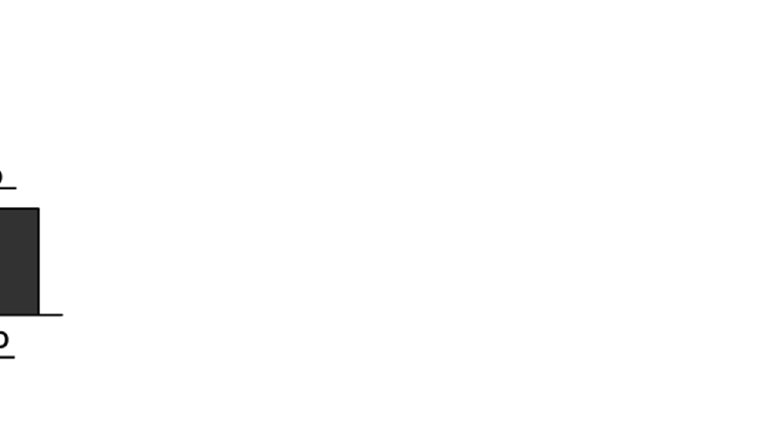
Figure 10. Partial replacement of dietary fat with PO or CO and LPS challenge on mRNA expression related to inflammation in EAT. Mice were fed either an ND or an ND partially replaced with PO or CO for 12 weeks and then treated with LPS (1 mg/kg) for 24 h ( n = 8 per group). ( A ) Interleukin (IL)-6 levels; ( B ) IL-1 β levels; ( C ) tumor necrosis factor (TNF)- α levels. The expression of each protein was normalized to a value for glyceraldehyde 3 phosphate dehydrogenase (GAPDH). Relative expression of each gene was quantified by using the 2 −ΔΔ CT method. Values are presented as the mean ± standard deviation. Data were analyzed using one-way ANOVA followed by Tukey’s post hoc test. Labeled means without a common letter differ ( p < 0.05).